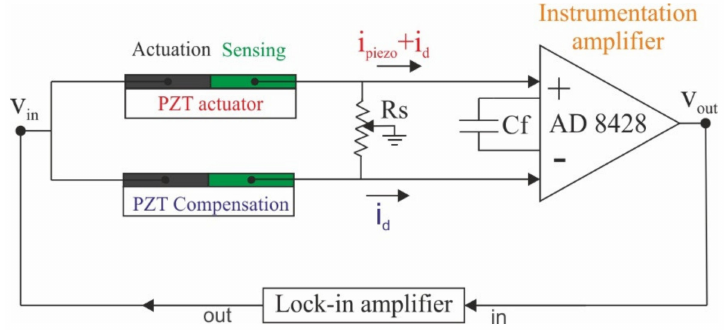
Figure 4. Schematic of the interface circuit designed for the open-loop